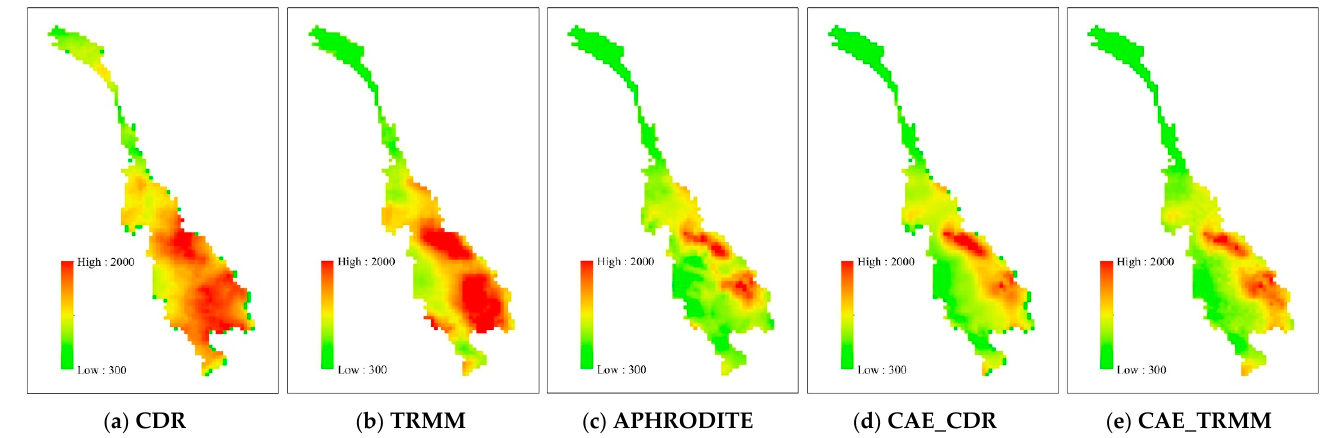
Figure 8. Spatial rainfall distribution of products over the MRB in the dry season of 2014.